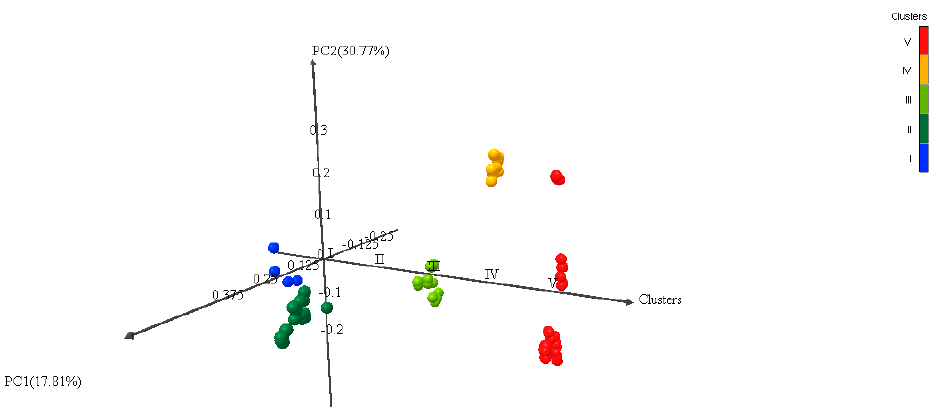
Figure 4. Two-dimensional principal coordinate analysis (PCoA) of 79 accessions of G. barbadense and G. darwinii collected from the Galapagos Islands. Blue (Cluster I), Green (Cluster II), Light green (Cluster III), Orange (Cluster IV), Red (Cluster V). Table 2. Summary of analysis of molecular variance (AMOVA).